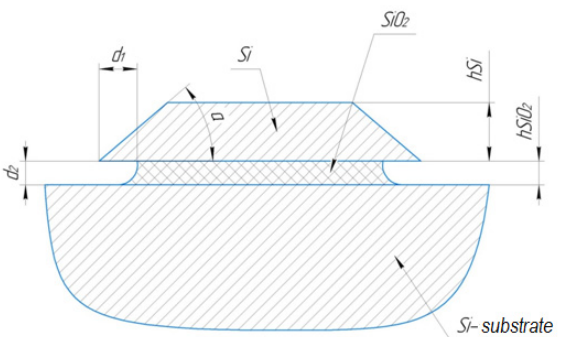
Figure 1. Sketch of the cross-section of the structure of the silicon WGM waveguide, environment is air: hSi—the thickness (height) of the wedge-shaped waveguide; hSiO2—thickness (height) of the dielectric layer; d1—distance from the edge of the wedge to the beginning of the oxide beam (support); d2—the gap between the edge of the wedge-shaped waveguide and the Si substrate; a—wedge angle .